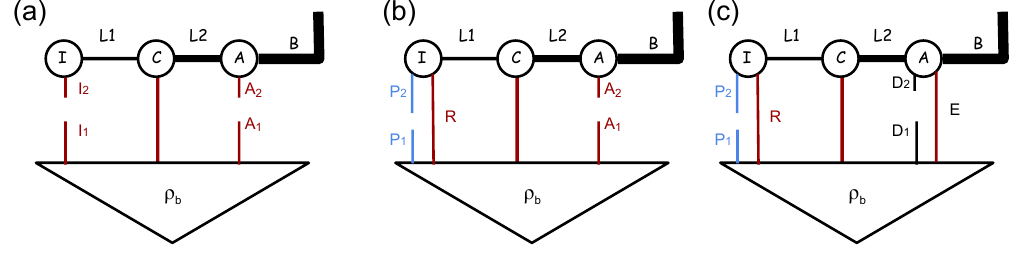
Figure 18. The super-density operator with (a) two ancilla coupled to I and A respectively; (b) two ancilla coupled to A and a part of I , denoted as P ; (c) two ancilla coupled to a part of A , denoted as D , and a part of I , denoted as P